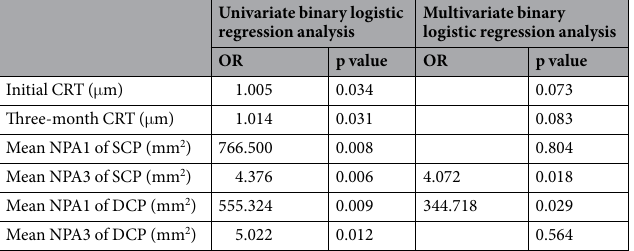
Table 4. Binary logistic regression analysis of recurrent macular edema secondary to branch retinal vein occlusion. CRT = central retinal thickness; DCP = deep capillary plexus; NPA1 = nonperfusion area in the 1-mm zone; NPA3 = non-perfusion area in the 1–3-mm zone; OR = odd ratio; SCP = superficial capillary